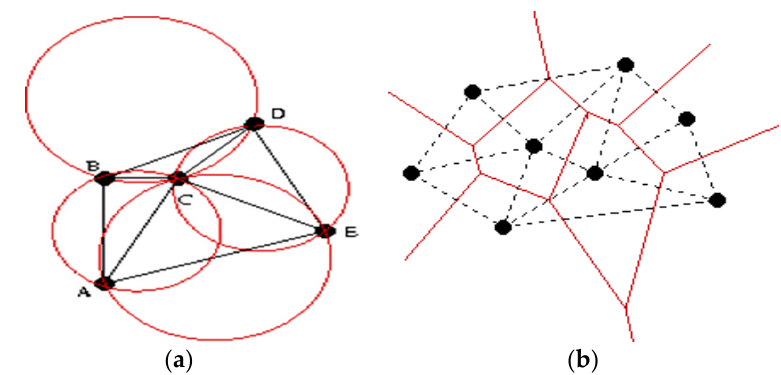
Figure 22. Representations of the Delaunay triangulation ( a ), Voronoi diagrams combined with the Delaunay algorithm ( b ).